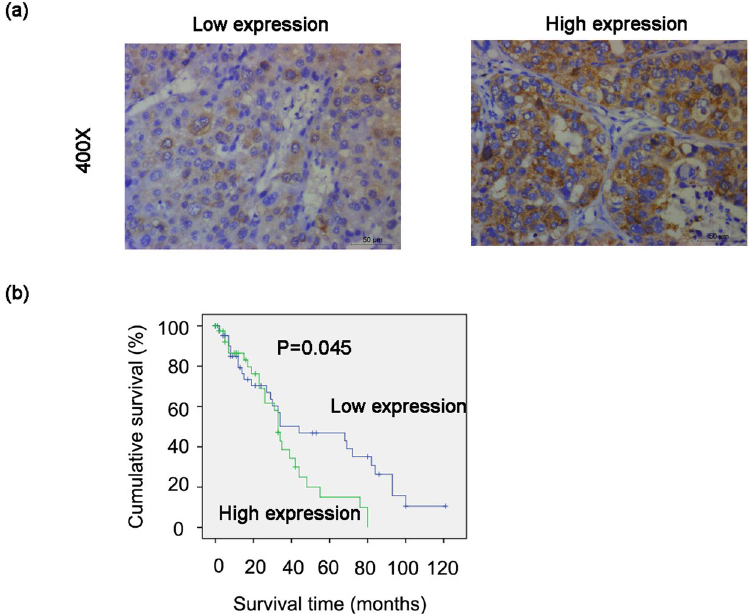
Figure 7. High expression of GTSE1 in HCC predicts a poor prognosis. ( a , b ) Kaplan-Meier analysis for the expression of GTSE1.